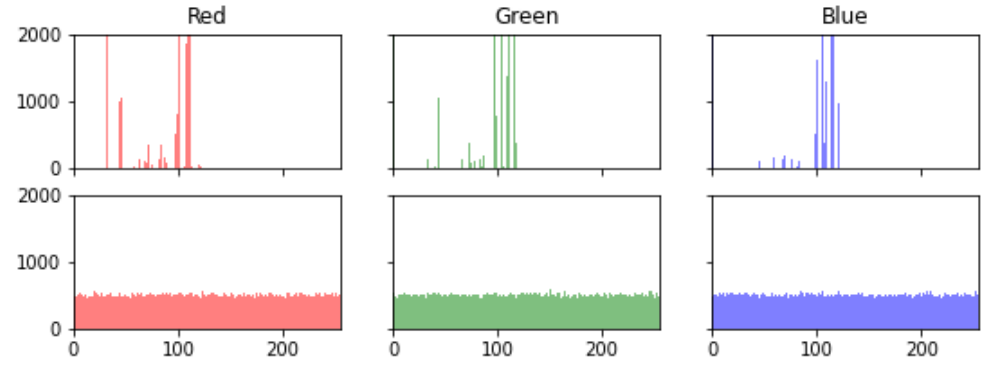
Figure 8. Histogram of the R, G, and B components of the pixels of the image version of Test File 2 ( top row ) and its cipher-image ( bottom row ).